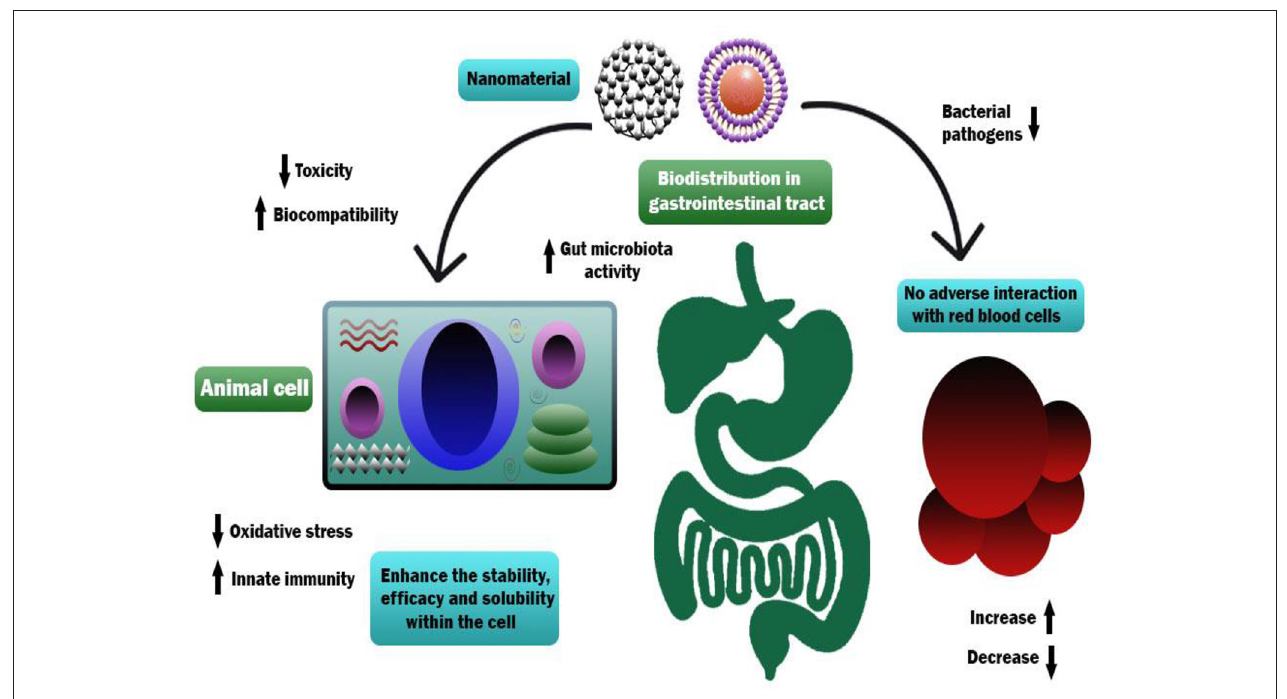
FIGURE 1 | Action mechanism of various biocompatible nanomaterials in human